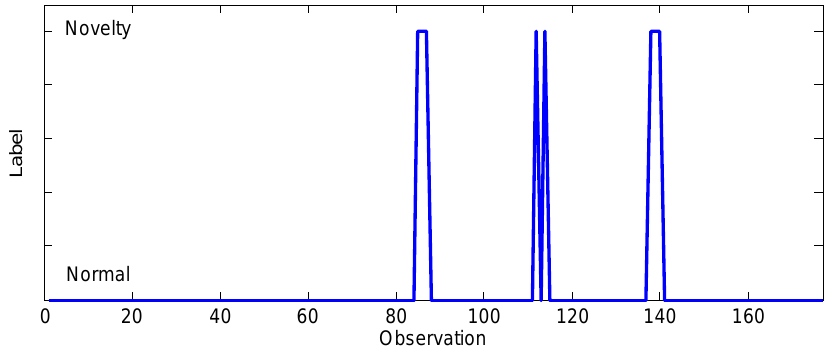
Figure 3. Discordant observations at novelty detection for